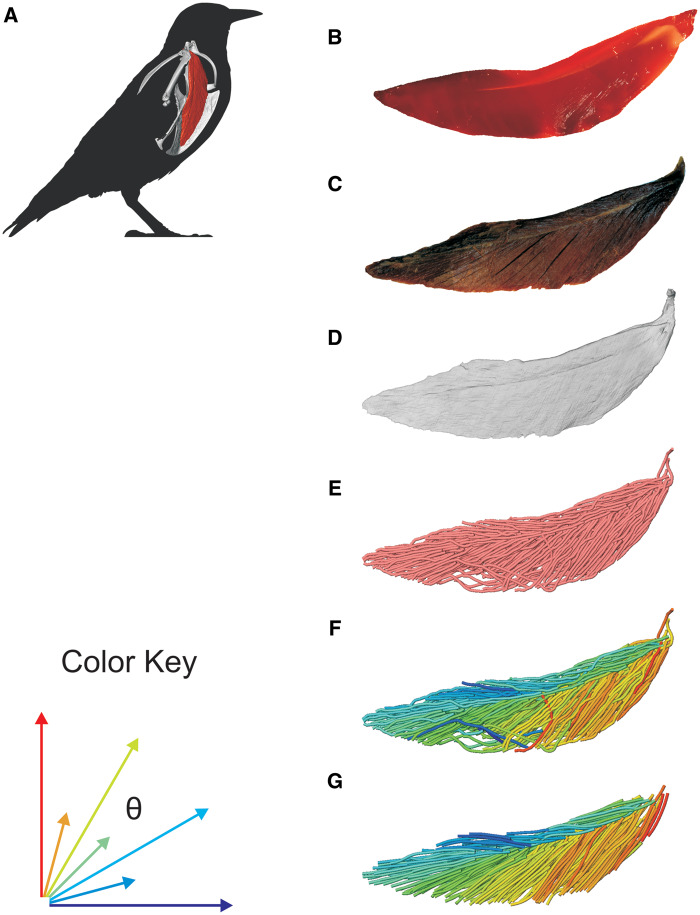
Diagrammatic workflow of volume and tract-model creation. All muscle photographs and illustrations depict a lateral view of the right m. supracoracoideus. (A) Starling (S. vulgaris) silhouette indicating the location of the right m. supracoracoideus within the pectoral girdle. (B) Fresh muscle. (C) Muscle after formalin fixation and contrast-enhancement via iodine potassium iodide. (D) Segmented muscle volume rendering. (E) Initial Xfiber fascicle-tract model. (F) Model in (E) colored by tract orientation. (G) Final, edited model. Colors in (F) and (G) represent angle θ, a proxy for pennation angle, which ranges from 0° to 90° (see Color Key).